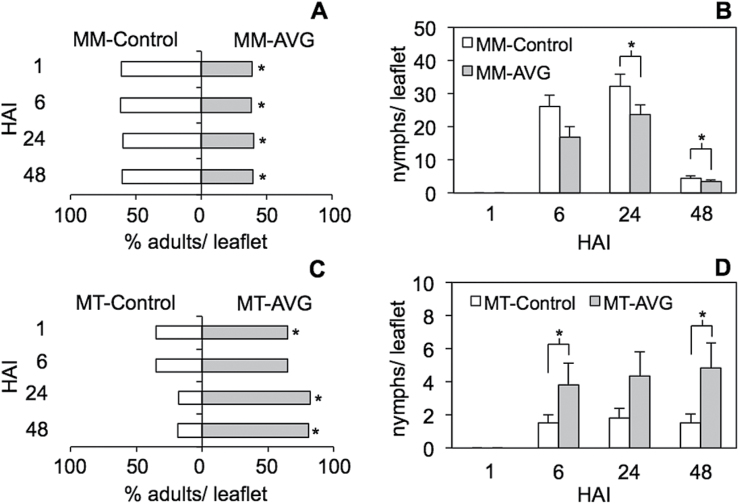
Aphid host preference between plants with and without an inhibitor of ethylene synthesis. The aphid-susceptible cultivar ‘MoneyMaker’ (MM) and the near-isogenic resistant line ‘Motelle’ (MT) were treated with an inhibitor of ethylene synthesis (AVG) or mock treated with solvent (control). To determine if aphids had a preference between AVG-treated or mock-treated plants, adult aphids were placed on choice arenas between paired plants and allowed to move back and forth between the plants (20 aphid per /area; six arenas per comparison). The percentage of adults that were located on treated plants versus controls (A, C) was recorded at 1, 6, 24, and 48 HAI, along with the number of offspring produced on each treatment group (B, D). Comparisons labelled with an asterisk (*) were statistically different at α=0.05 according to one-sided matched-pair comparisons. Error bars in (B) and (C) represent SEM.